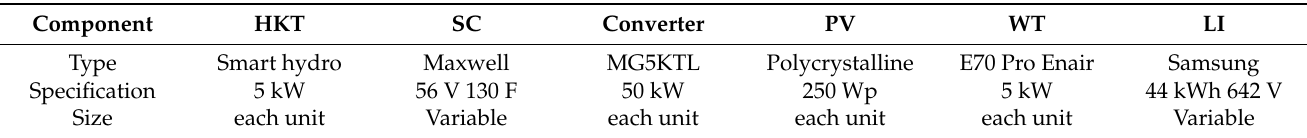
Figure 5. Connection diagram of the laboratory equipment used in this experiment. Table 1. Technical characteristics of the microgrid laboratory equipment at the University of Cuenca [39].